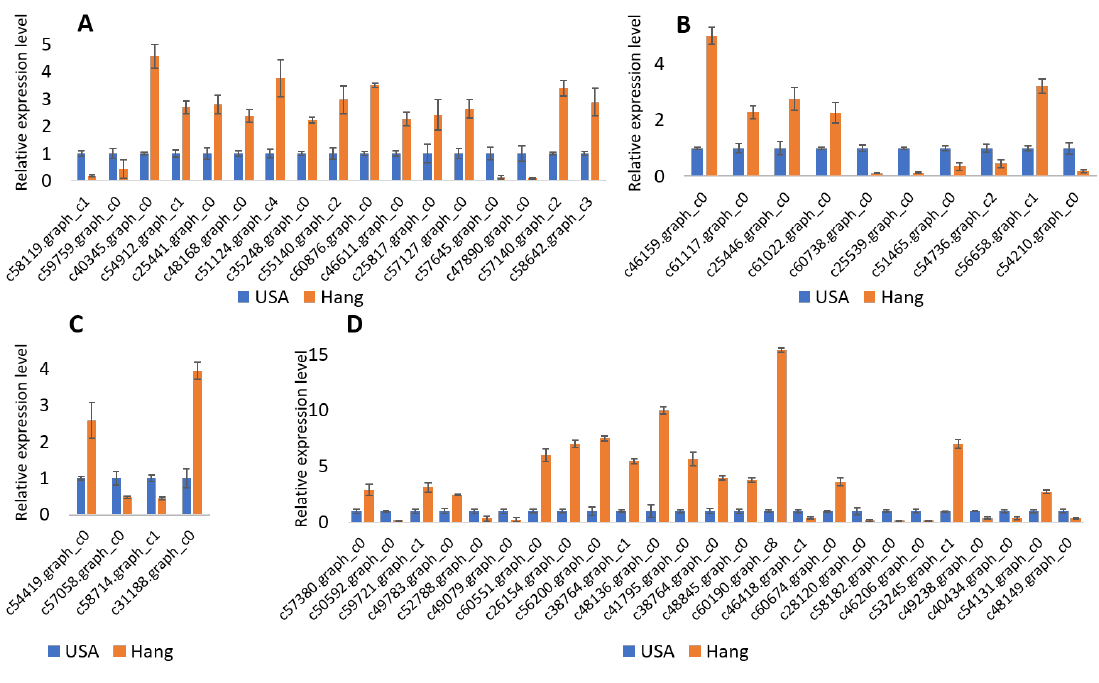
Figure 4. qRT-PCR results of genes related to bottle gourd fruit size. ( A ) Genes related to cell wall metabolism during fruit development; ( B ) Genes related to hormones involved in fruit development; ( C ) Genes controlling cell cycle and cell division during fruit development; ( D ) Transcription factors regulating fruit size.